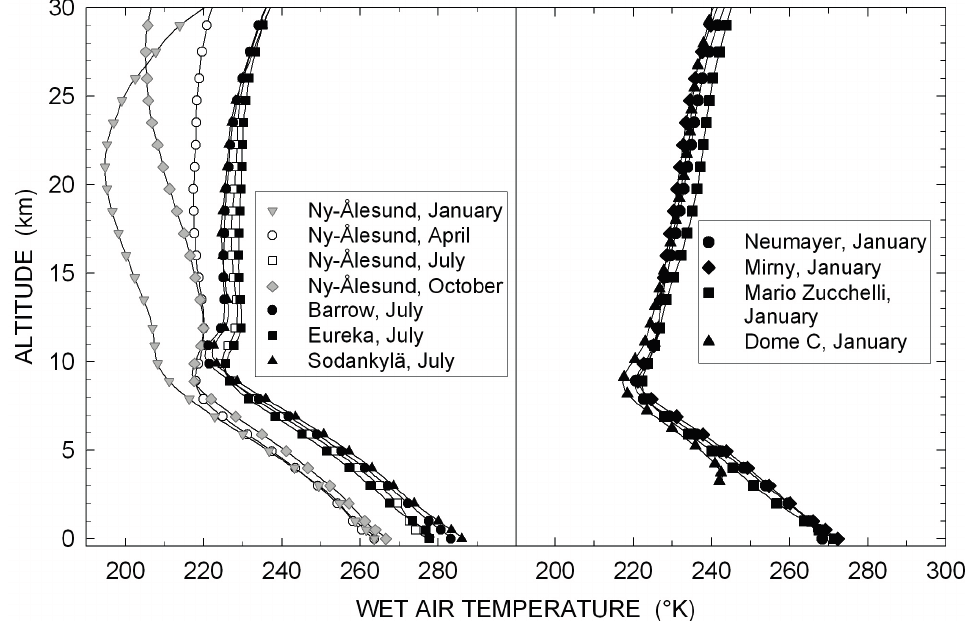
Figure 1. Monthly mean vertical profiles of wet air temperature T ( z ) derived over the 0  z  30 km altitude range from the multi-year radiosounding datasets collected at Ny-Ålesund in four different months and at three other Arctic sites in July (left-hand side), and at four Antarctic sites in January (right-hand side). Note that the vertical profile of T ( z ) (solid triangles) measured at Dome C on the Antarctic Plateau starts at the (surface-level) altitude of 3.233